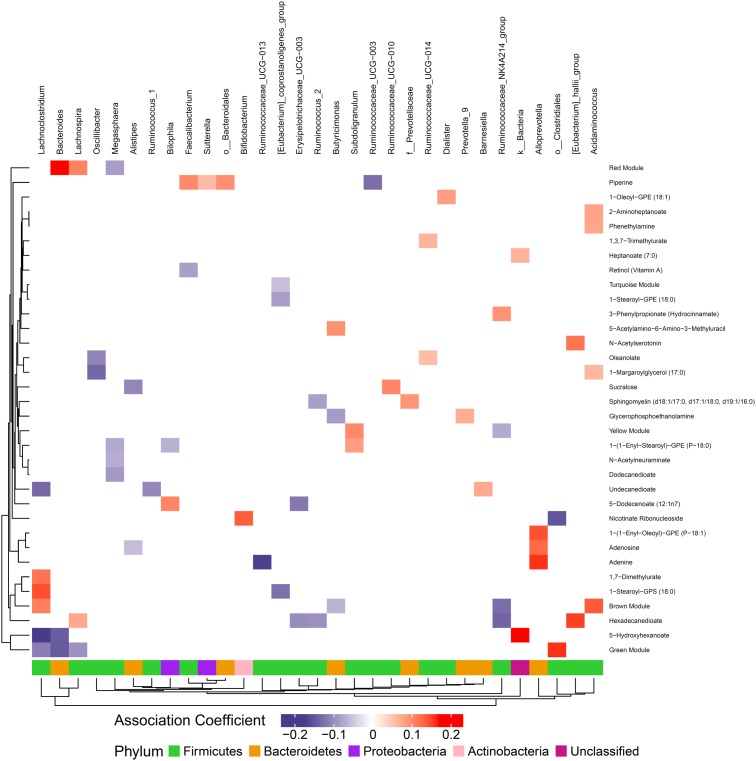
Associations between gut microbiome and metabolites in stool. Color intensity reflects the magnitude of the association coefficients between metabolites and taxa.